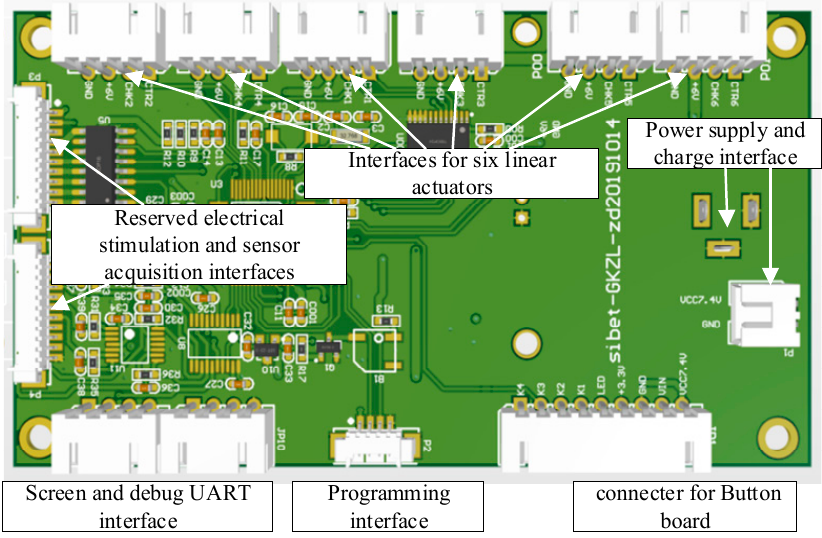
Figure 6. The main control circuit diagram of the rehabilitation robot.